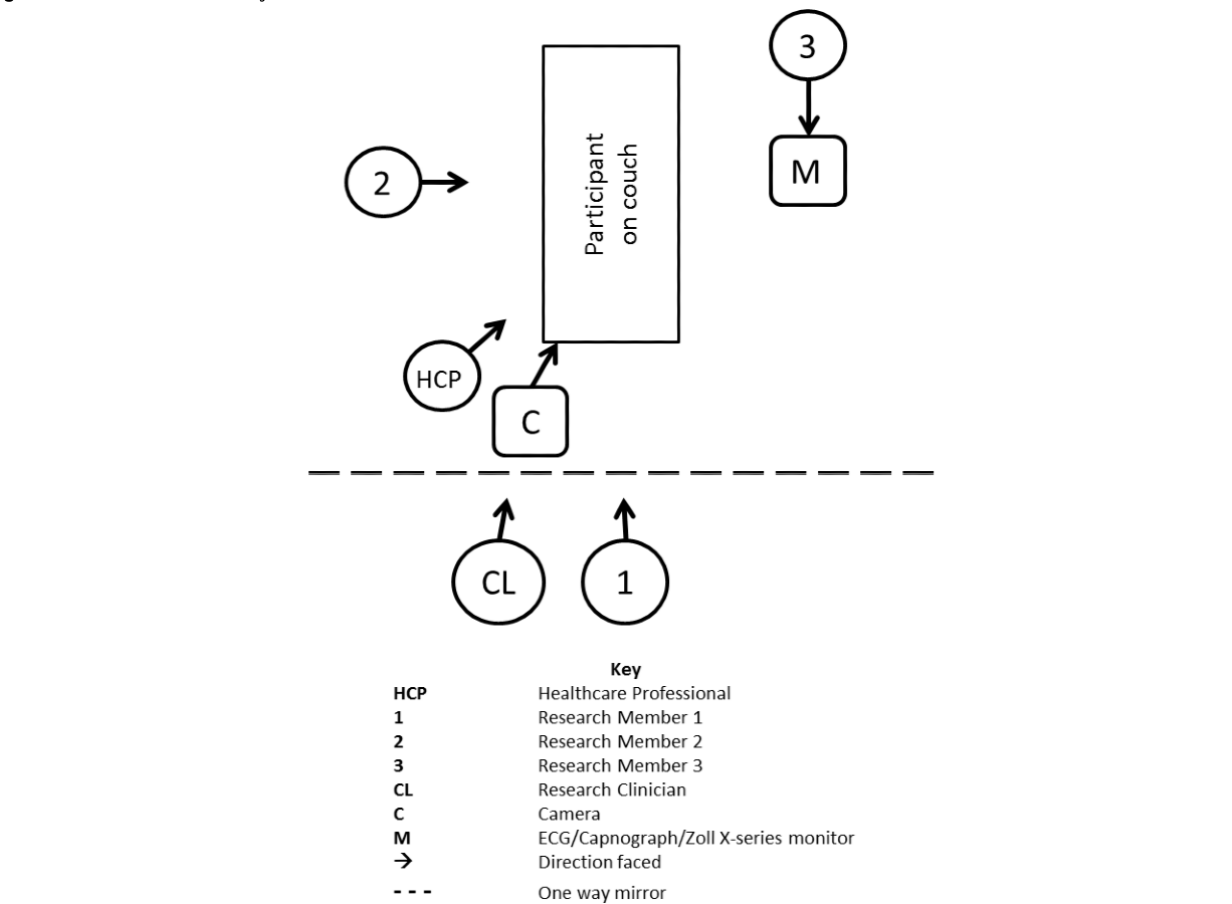
Figure 2. Schematic of room